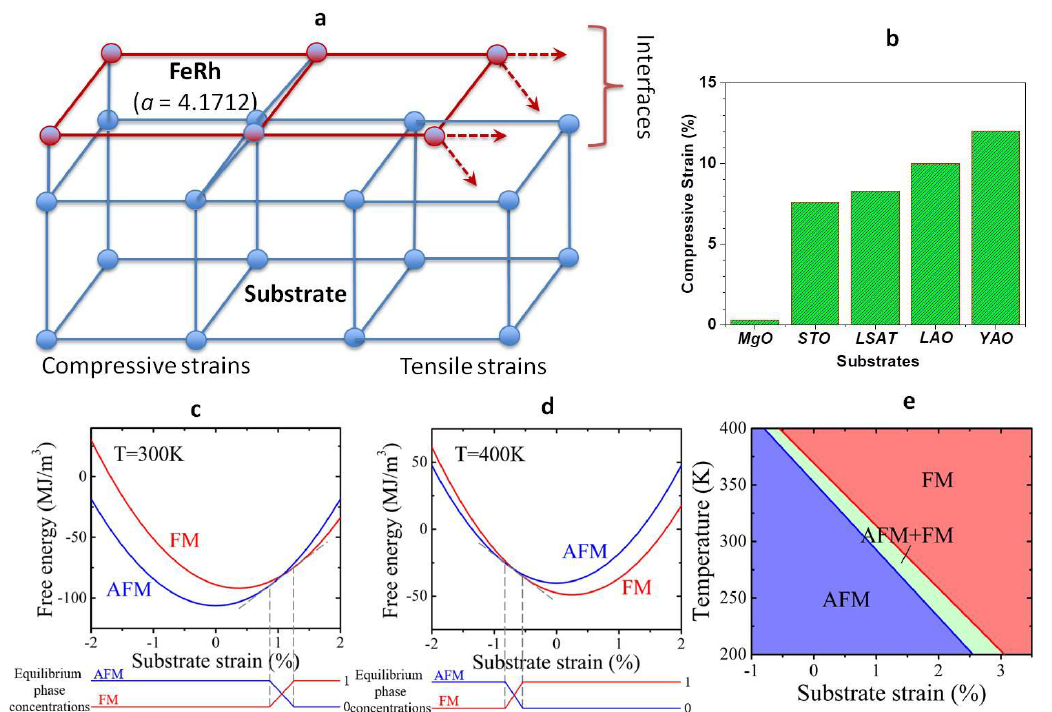
Figure 1. Model structures. ( a ) Schematics of the lattice deformation of the FeRh films. ( b ) Naturally induced strains of FeRh films on different substrates. ( c–d ) Calculated free energies of the ferromagnetic (FM) and antiferromagnetic (AFM) phases and their equilibrium phase concentrations as a function of substrate strains at ( c ) 300K and ( d ) 400K, respectively. ( e ) Calculated temperature–substrate strain phase diagram.